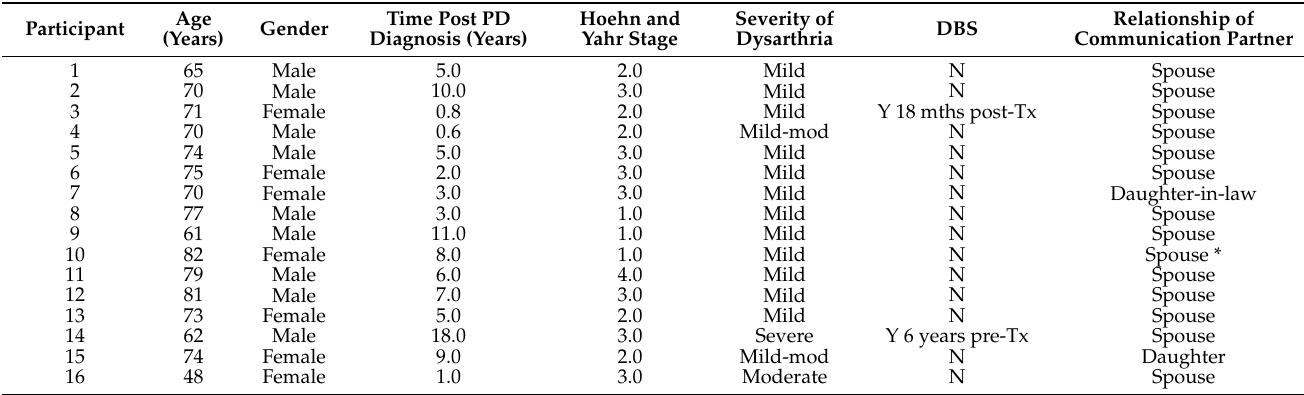
Table 1. Demographics of participants with